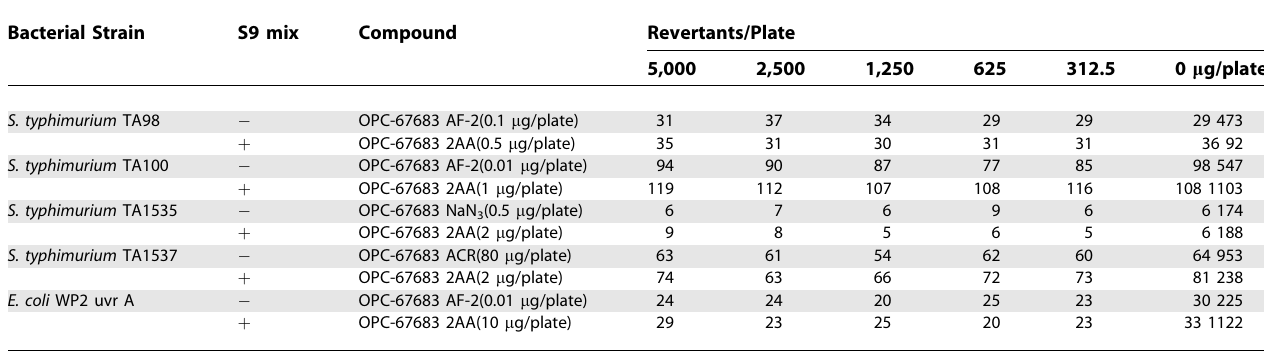
Table 1. Bacterial Reverse Mutation Test for